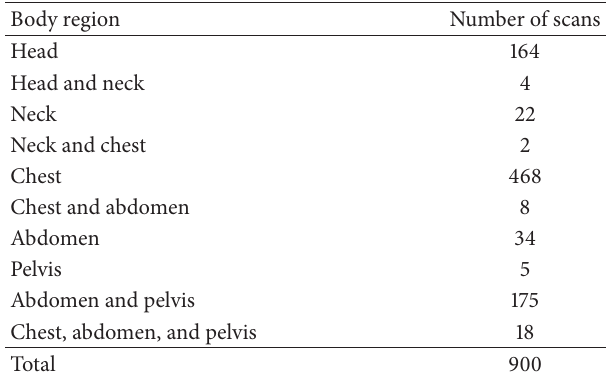
Table 2: CT scans performed over the 4-year period including the initial CTA for PE evaluation.